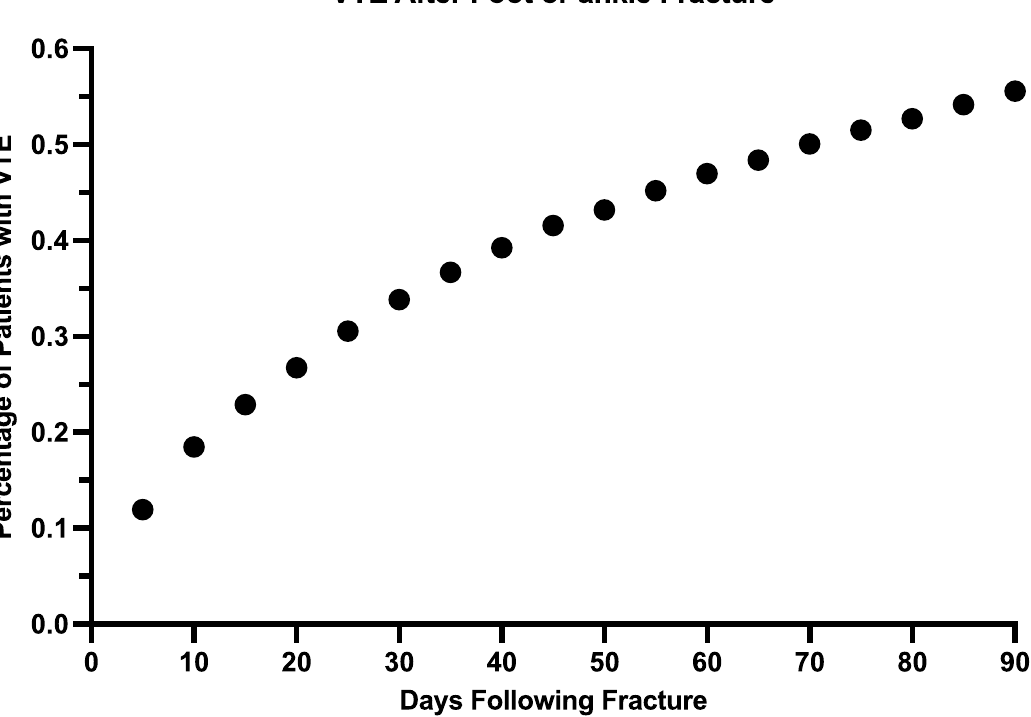
By multivariate analysis, factors associated with VTE (in decreasing order) were: prior VTE (OR: 25.44, 95% CI: 19.70–33.29), factor V Leiden (OR = 24.34, 95% CI: 16.96–33.29), active cancer (OR = 1.84, 95% CI: 1.30–2.60), specific fracture relative to metatarsal fracture (multi- ple fractures [OR: 1.51, 95% CI: 1.22–1.85], ankle fracture [OR = 1.51, 95% CI: 1.35–1.69], and calcaneus fracture [OR = 1.24, 95% CI: 1.00–1.53]), surgical treatment (OR = 1.41, 95% CI: 1.15–1.72), male sex (OR = 1.19), greater Elixhauser index (OR = 1.05, 95% CI: 1.04–1.06), and increasing age (OR:1.05 per decade, 95% CI: 1.01–1.08) (p < 0.05 for each).These results are shown in Table 2.